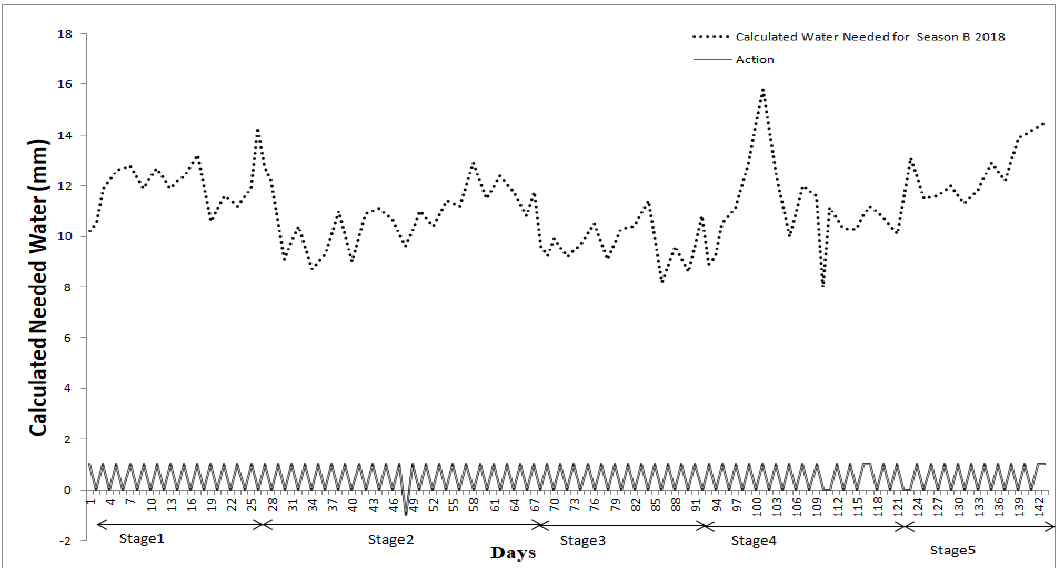
Figure 6. Calculated needed water output by the system for Season B 2018 using the Markov chain process and SARSA. The simulated fault when the model switched to SARSA is Days 110 to 116. The irrigation action taken each day is indicated with values of irrigate (1), not irrigate (0), and extract water ( −